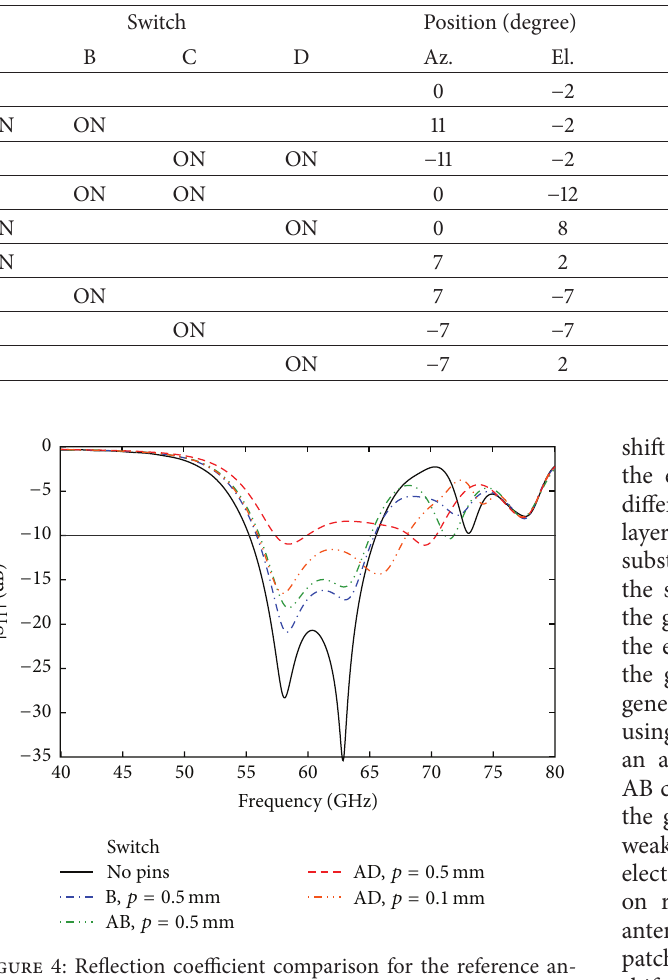
Figure 4: Reflection coefficient comparison for the reference an- tenna and for the reconfigurable antenna with different beam shift